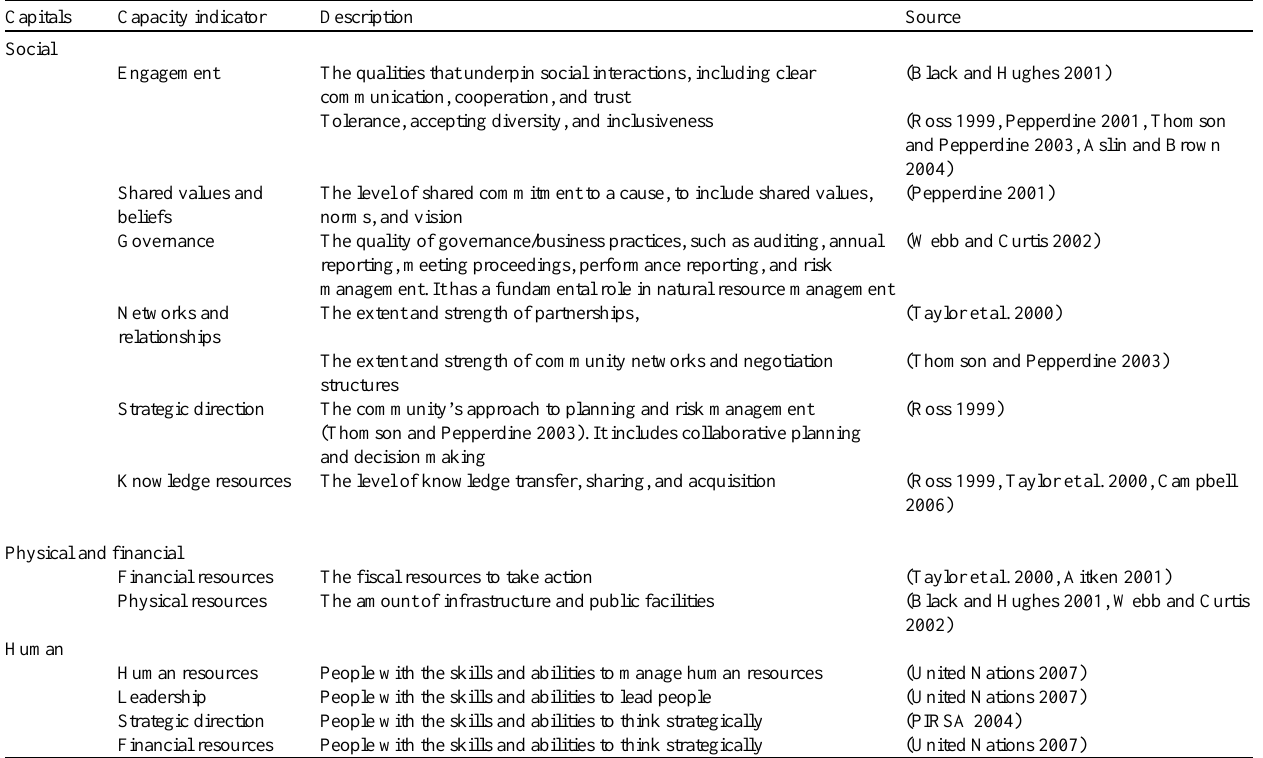
Table 2. Indicators of capacity, as originally identified by the project team based on a review of the literature